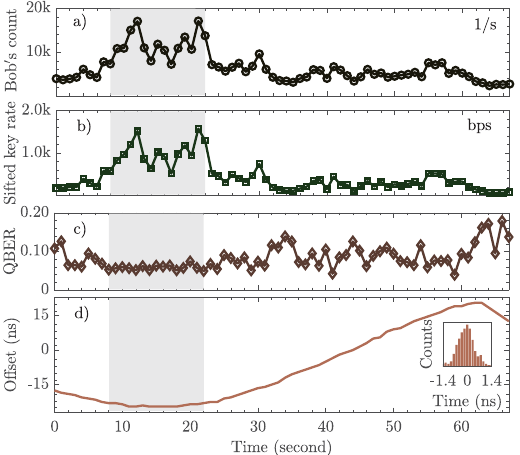
Fig. 3 Performance of the free-space link over time. One of the photons is detected in Alice ’ s laboratory at a rate of 13.3 Mcps, while the polarization-entangled partner photon is sent over the free-space link. a Due to atmospheric turbulence, the rate of single photons Bob receives is varying over time. Each data point corresponds to an integration time of 1 s. b Sifted key rate and c Quantum bit error rate (QBER) of the BBM92 protocol 41 . d Relative clock drift between Alice and Bob around the time- of- fl ight offset of 478.12 μ s. The inset depicts the normalized correlation peak of two-photon detections after time synchroni- zation with a resolution of 156 ps.